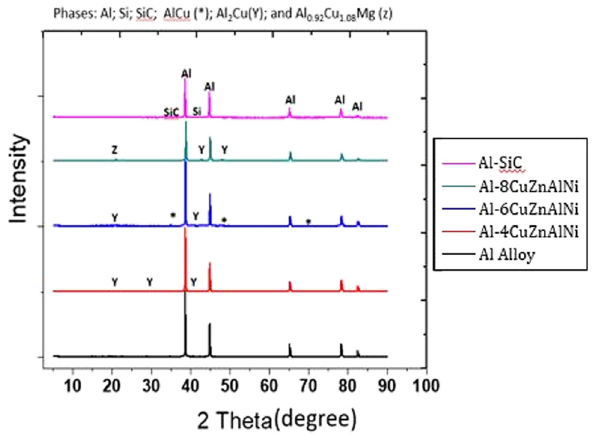
Figure 3: XRD pattern of the